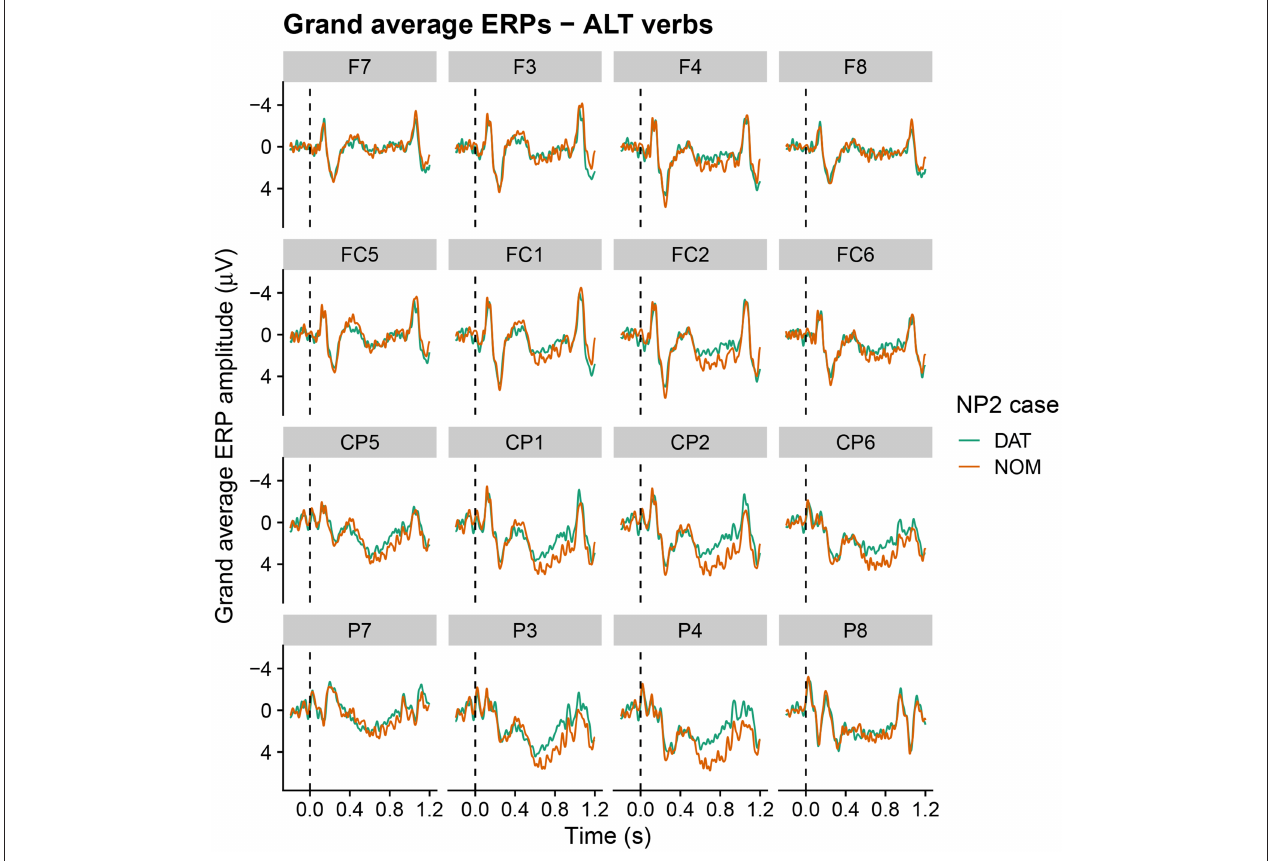
FIGURE 4 | Grand average ERPs at the critical NP2 position for sentences with alternating verbs (onset at the dashed vertical line). Negativity is plotted